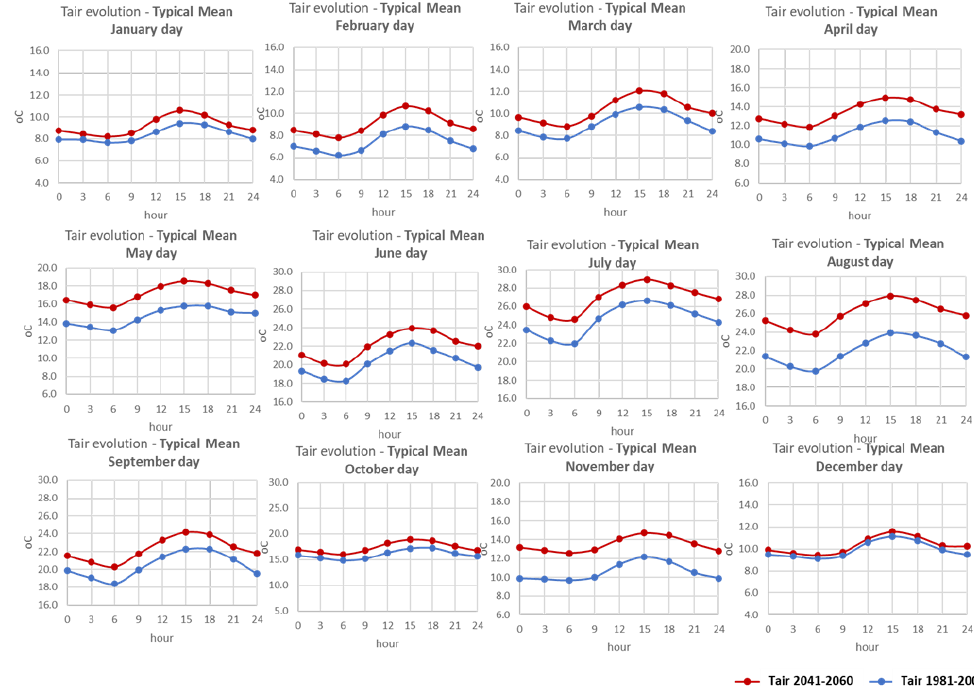
Figure 4. Hourly air temperature evolution for the typical mean days of each month and for the periods 1981 – 2000 and 2041 – 2060.